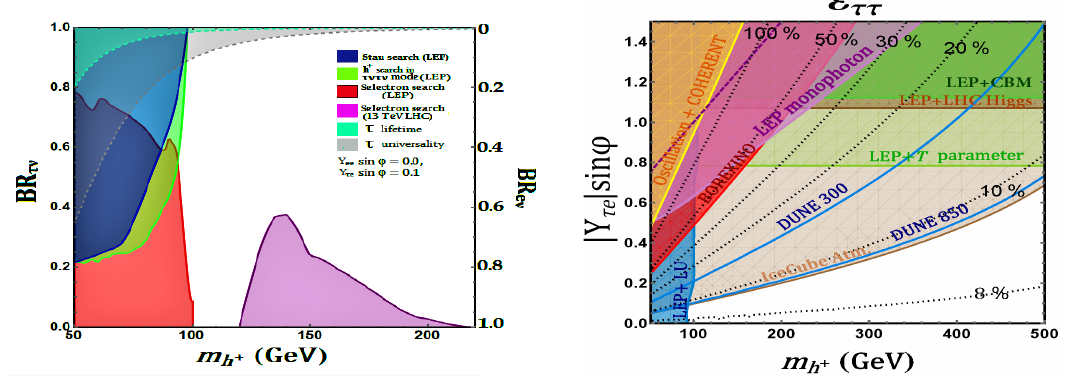
Figure 7.2: (a) Collider constraints on light charged higgs in the Zee model. (b) (cid:34) ττ prediction. The shaded regions are excluded. See text and Ref.